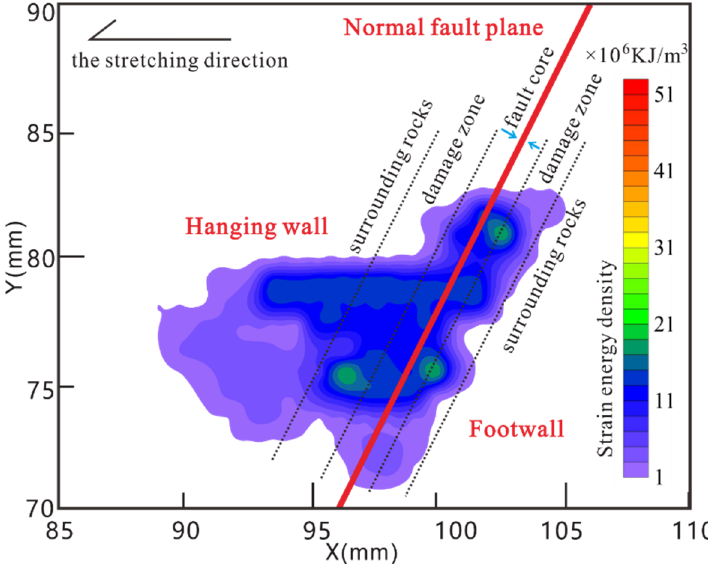
Figure 19. Schematic diagram of the five regions of a normal fault. Table 5. Range conversion table for each region of the normal fault in the prototype and experiment (L* = 2 × 10 − 5